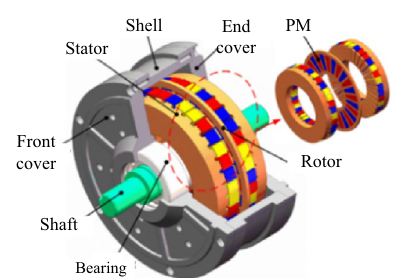
Figure 11 Structure of AFIR-S motor